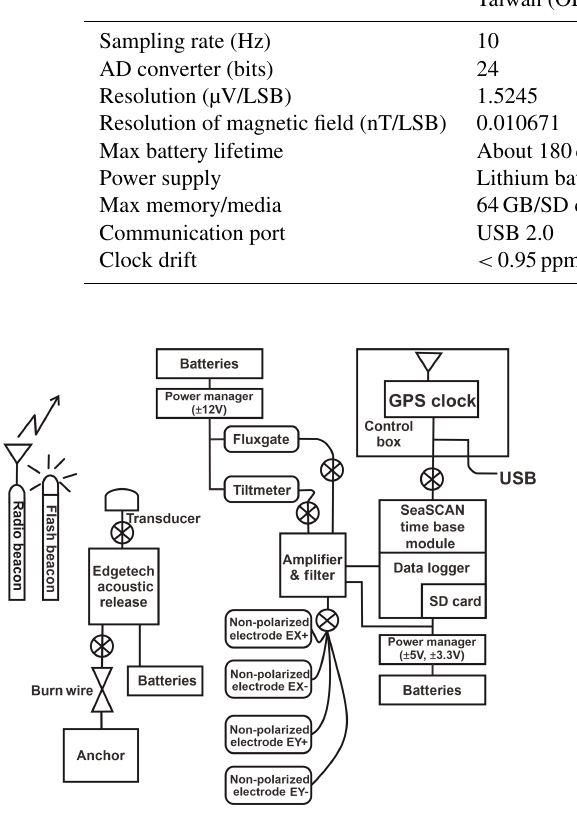
Figure 1. A block diagram of the OBEM. The inputs of the two electric fields, two inclinations and three magnetic fields pass through the Amp & LPF in the data logger, which contains a 64GB SD card. The SeaSCAN time base module is integrated into the data logger and has a timing error smaller than 3syr − 1 . The EdgeTech acoustic transceiver and transducer are used for the positioning and releasing of the anchor. The radio and flash beacons are used to lo- cate the OBEM at the sea surface during recovery